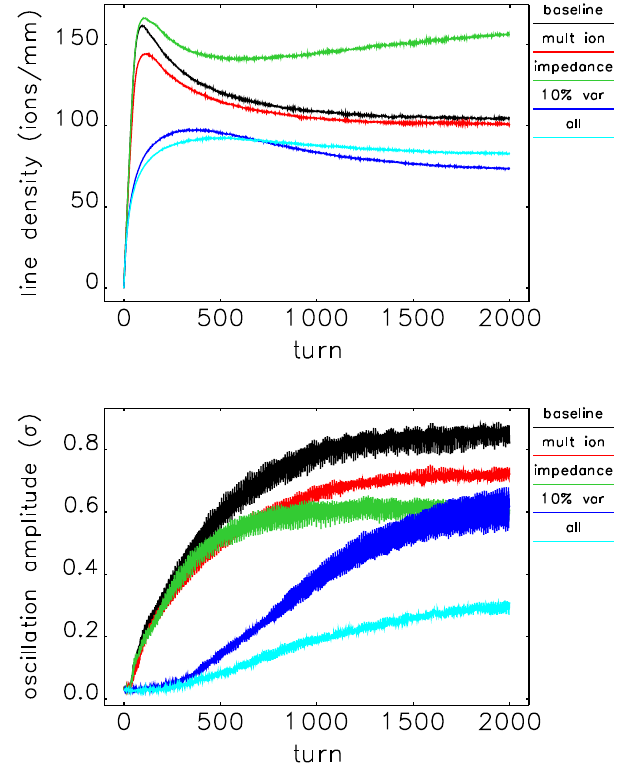
FIG. 8. Ion density (top) and instability amplitude (bottom), comparing different effects: multiple ionization (red), transverse impedance (green), and 10% rms charge variation (blue). The result of including all three effects is shown in cyan.